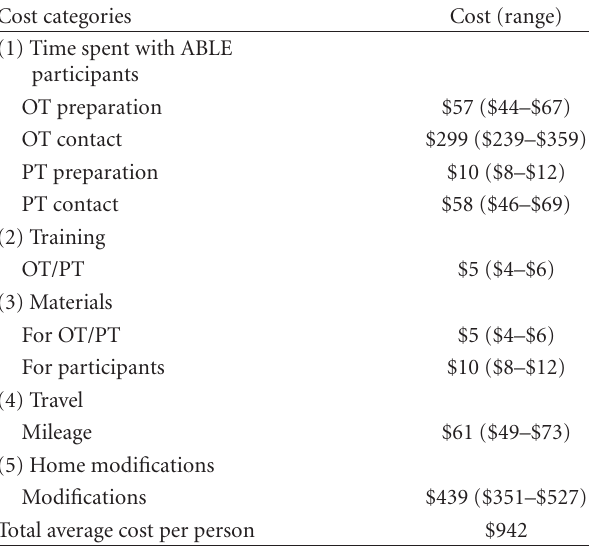
Table 2: Cost categories for ABLE